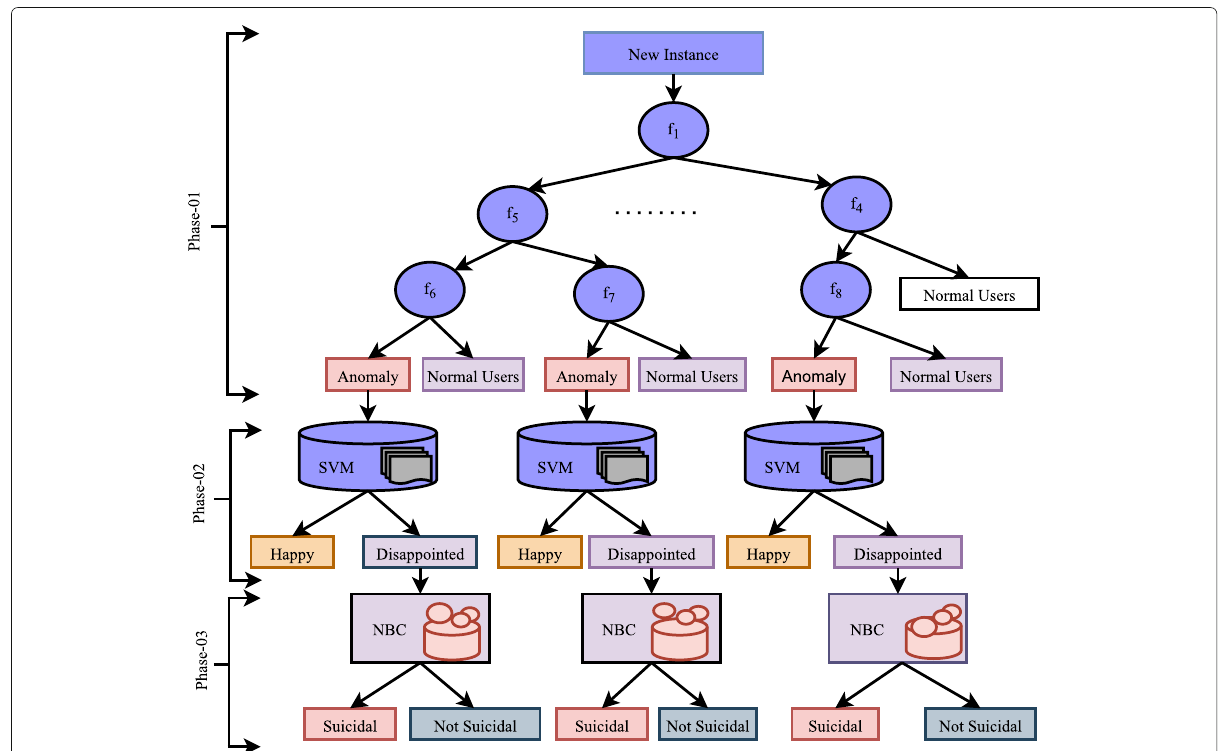
Fig. 4 Diagram of the decision making process of the proposed method